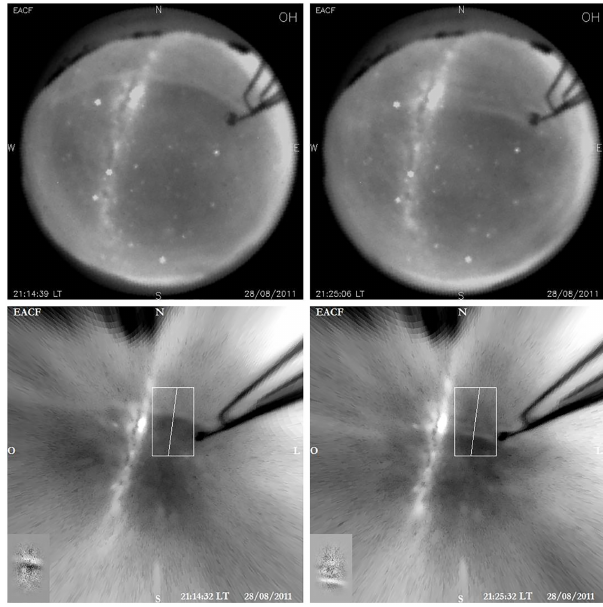
Figure 4. Same as Fig. 1 but for the mesospheric front characterized from 00:14 to 00:25UT 29